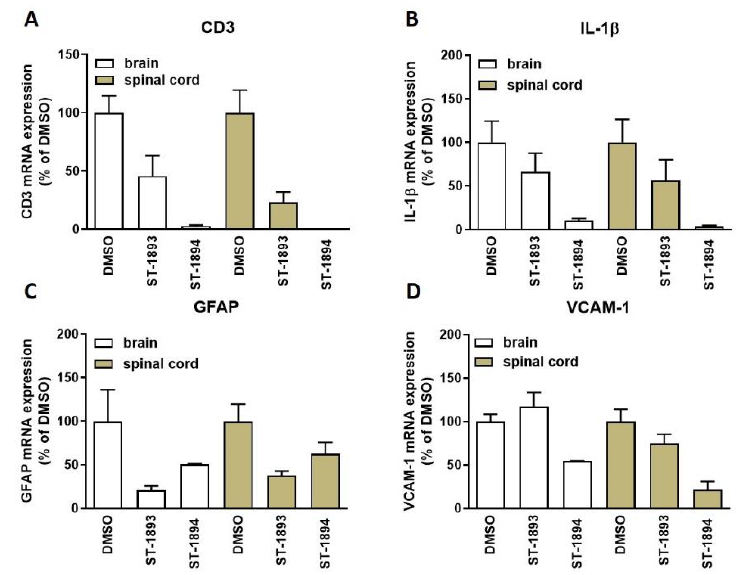
Figure 7. Analysis of the messenger RNA (mRNA) expression of several markers in the central nervous system (CNS) of EAE mice. CNS samples extracted from perfused EAE mice on day 21 were homogenized as explained in Section 4 and were taken for extraction of RNA. Complementary DNA (cDNA) synthesis and quantitative PCR analysis were performed, and primers for cluster of differentiation 3 (CD3) ( A ), interleukin (IL)-1β ( B ), glial fibrillary acidic protein (GFAP) ( C ), and vascular cell adhesion molecule (VCAM)-1 ( D ) were used. Results are presented as a percentage of DMSO control and are means ± SEM ( n = 8, DMSO; n = 5, ST-1893; n = 2–3, ST-1894).